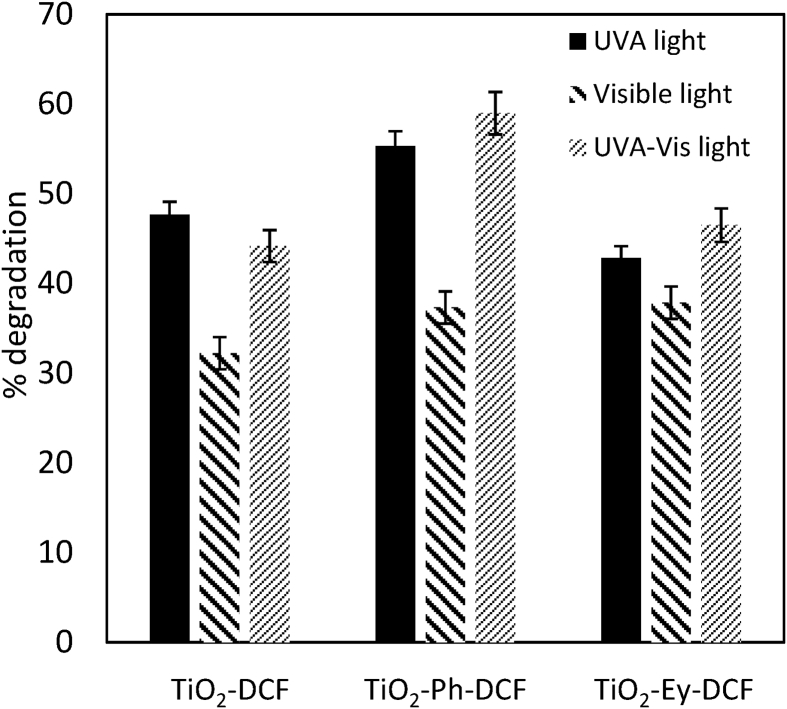
Comparison of diclofenac degradation by dye-sensitized of TiO2 under different sources of energy, [TiO2] = 0.35 g/L; [DCF] = 30 mg/L.